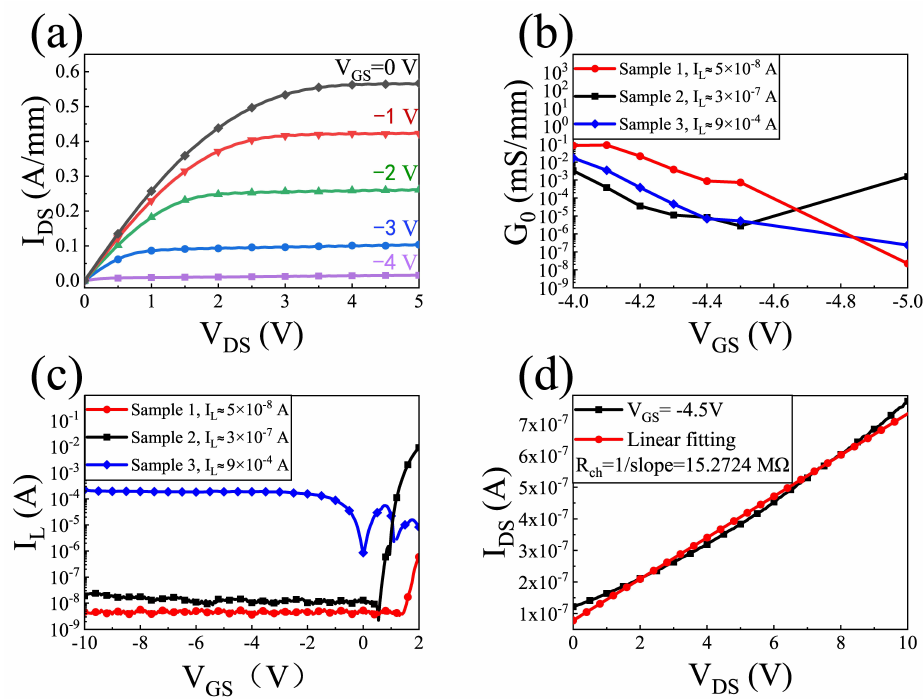
Figure 3. ( a ) I-V characteristics of sample 1. ( b ) Measured source–drain conductance ( G 0 ) as a function of the V GS in the subthreshold regime. ( c ) Different leakage currents of the three samples. ( d ) Output characteristics of sample 1 at V GS = − 4.5